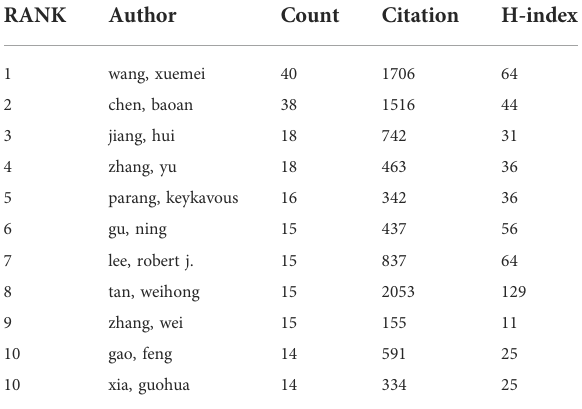
TABLE 4 The top 10 authors and co-cited authors of Nanoparticles- leukemia-related research.